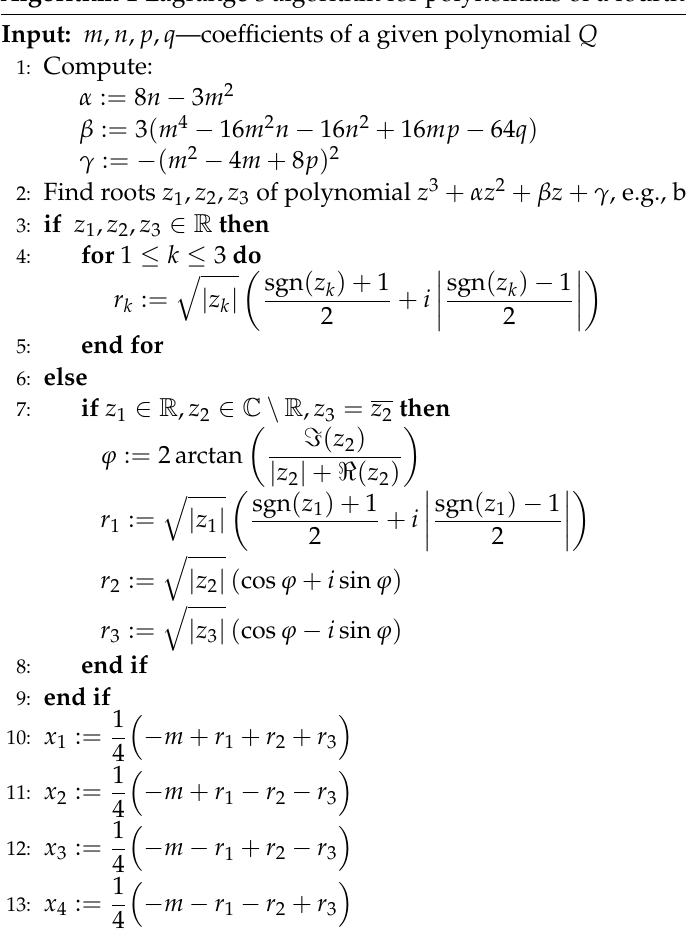
Algorithm 1 Lagrange’s algorithm for polynomials of a fourth